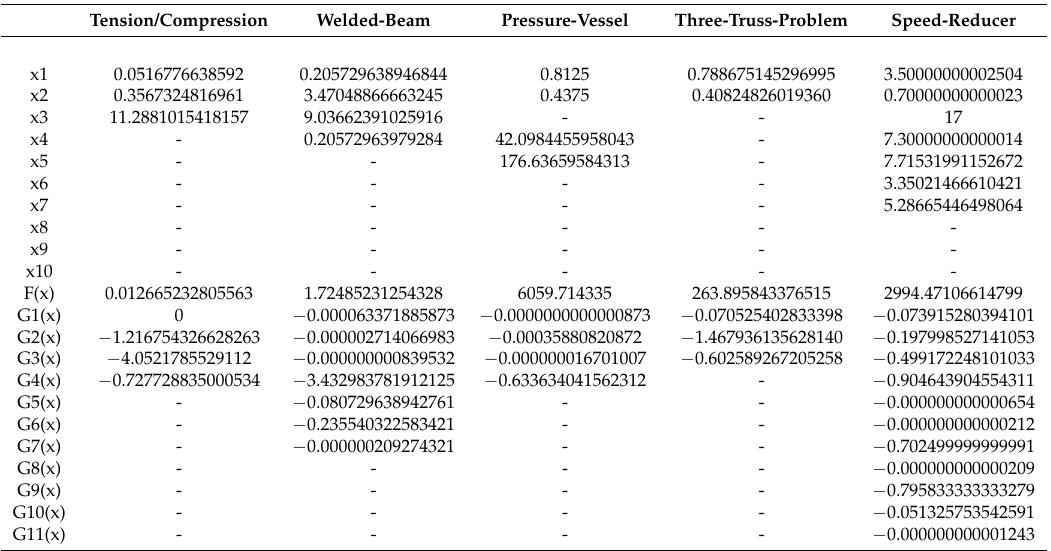
Table 9. Best outcomes of parameter objective and constraints values for over engineering-problems.